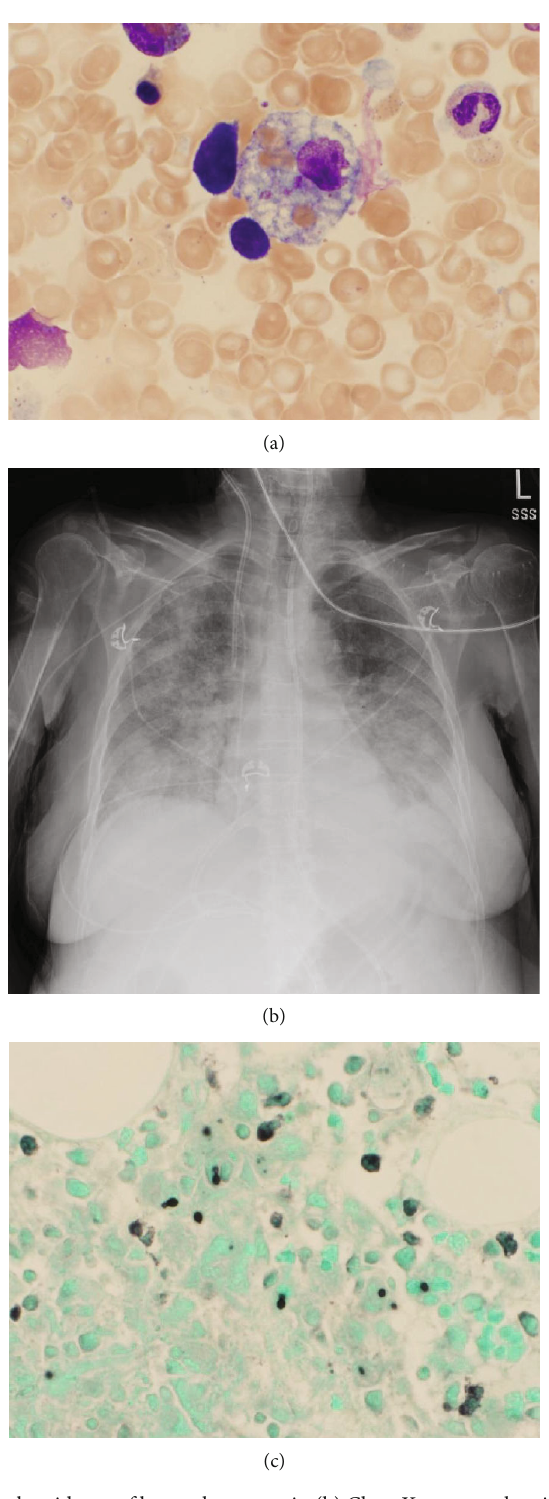
Figure 1: (a) Bone marrow aspirate reveals evidence of hemophagocytosis. (b) Chest X-ray reveals evidence of bilateral in fi ltrates, and patient then diagnosed with ARDS. (c) Bone marrow core biopsy GMS stain reveals